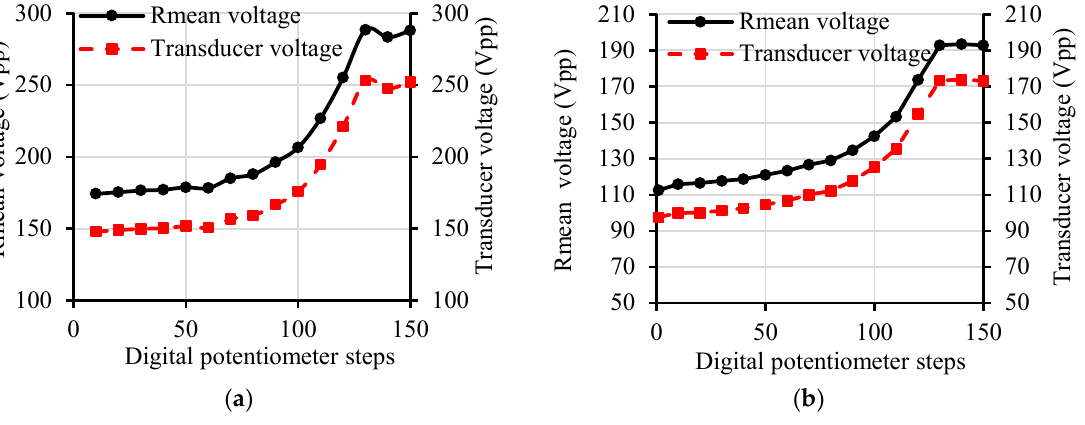
Figure 16. Relation between the measured Rmean and the transducer voltage with respect to the digital potentiometer steps for; ( a ) Transducer T1; and ( b ) Transducer T2.